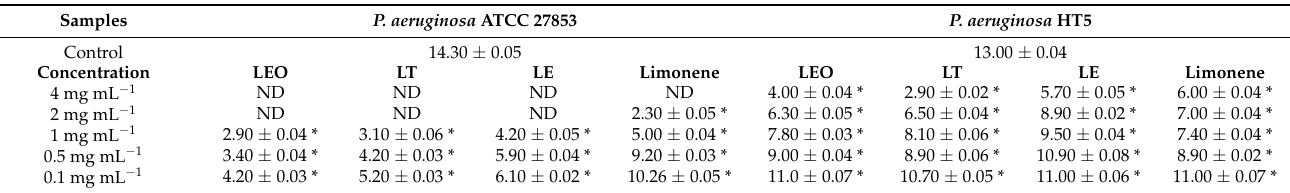
Table 4. Pseudomonas aeruginosa swarming